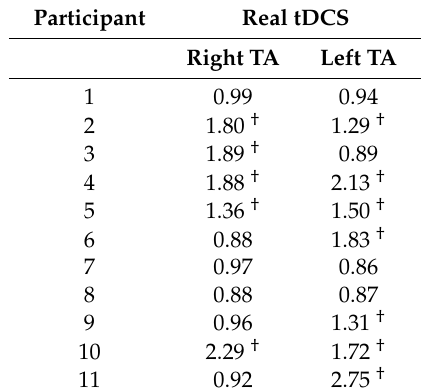
Table 2. Grand average of normalized mean MEP amplitude post real tDCS.